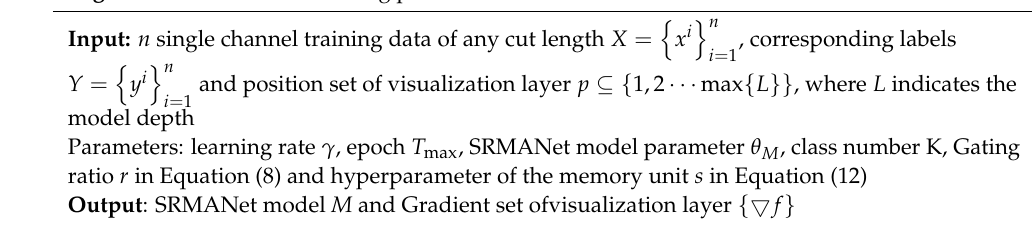
Algorithm 1: SRMANet training